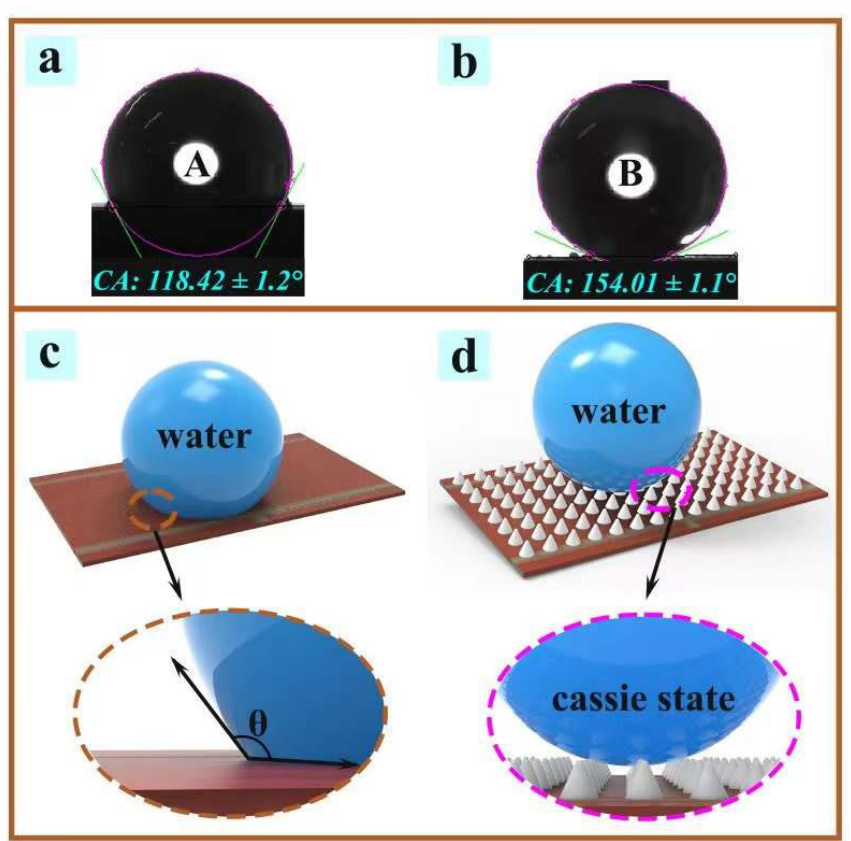
Figure 7. ( a ) Contact angle data of sample A's surface; ( b ) is the contact angle data of sample B's surface; ( c , d ) are the changes of the sample surface contact model before and after physical deposition of SiO 2 particles and their respective regional magnification diagrams.